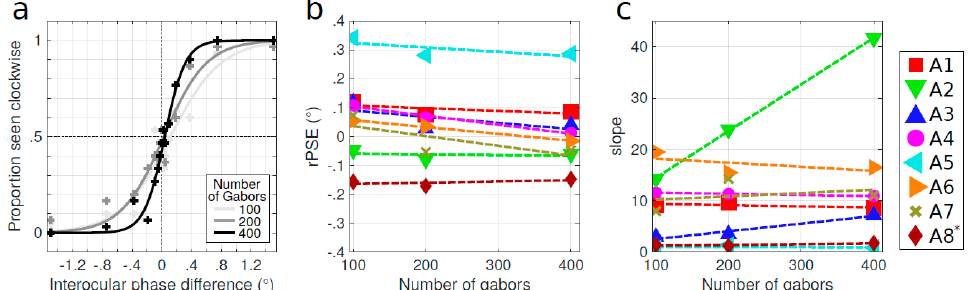
Figure 5. Effect of density. ( a ) Psychometric functions of the perceived direction of rotation for one representative amblyopic subject (A3) as a function of the interocular phase difference for three different numbers of Gabor patches composing the stimulus: 100 (light-gray symbols), 200 (mid-gray symbols), and 400 (dark-gray symbols). Data points are fitted by a logistic function. ( b ) Rectified PSE (rPSE) as a function of the number of Gabor patches for the eight amblyopic subjects. * rPSE values for subject A8 were divided by 10. ( c ) Slopes of the psychometric functions. Dashed lines represent linear regression. Quality of fit and regression parameters are reported in Table S1 (Supplementary Materials, Sheet 1).